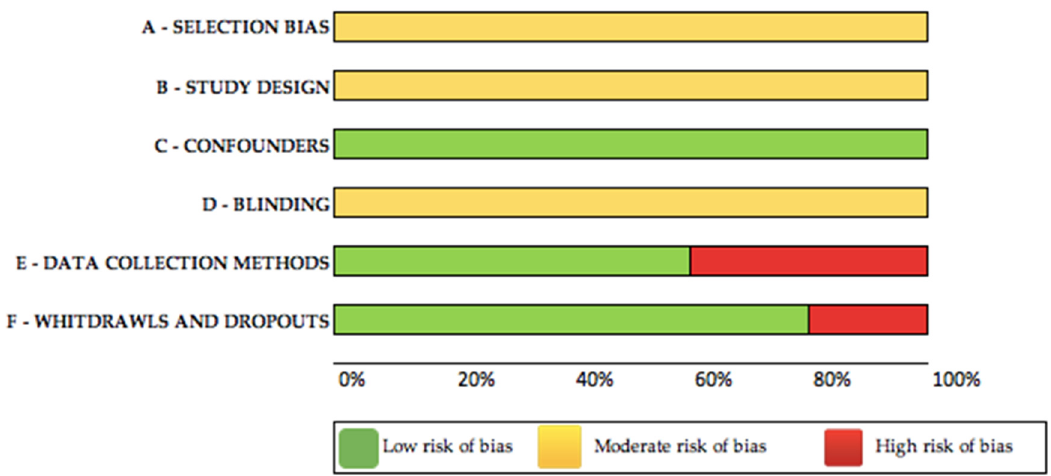
Figure 2. Bias Analysis Graph.